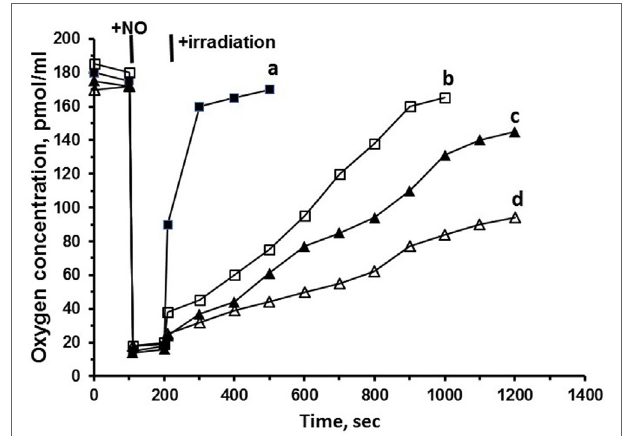
FigURe 4 | Effects of nitric oxide (NO) and laser irradiation on mitochondrial respiration. The studies of the regulatory physiological mechanisms of NO in mitochondria show that binding of NO by mitochondrial proteins results in the production of photosensitive nitrosyl complexes. The application of laser light irradiation is an effective approach to nitrosyl complex decay. The efficacy of laser photolysis depends on the wavelength of the radiation applied. This issue was addressed in a previous study performed in our laboratory (22). Rat liver mitochondria [0.1 mg of protein/ml in a buffer consisting of 105 mM KCl, 20 mM Tris–HCl, 1 mM diethylenetriaminepentaacetic acid, 5 mM